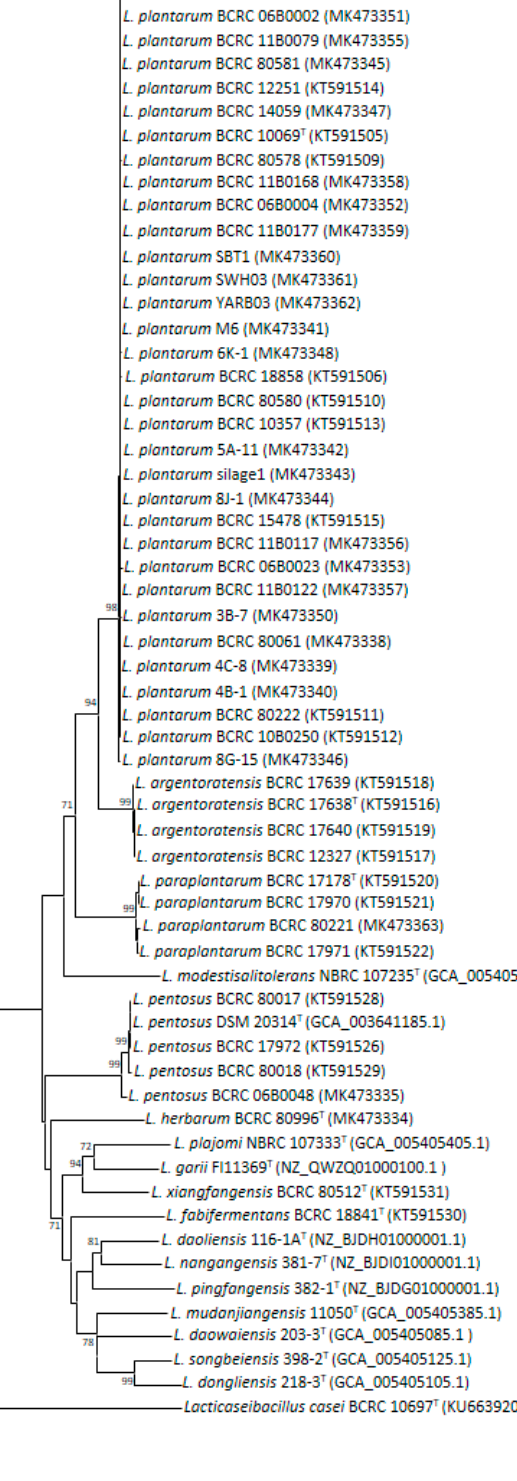
Figure 1. Phylogenetic tree of 57 L. plantarum group strains based on mutL sequences. The tree was constructed with the neighbour-joining method. Genetic distances were computed by Kimura’s two-parameter model. L. casei was included as an outgroup. Only bootstrap percentages above 70% are shown (based on 1000 replications). The scale bar represents 0.1% sequence divergence. Table 3. Species-specific primers used in this study.